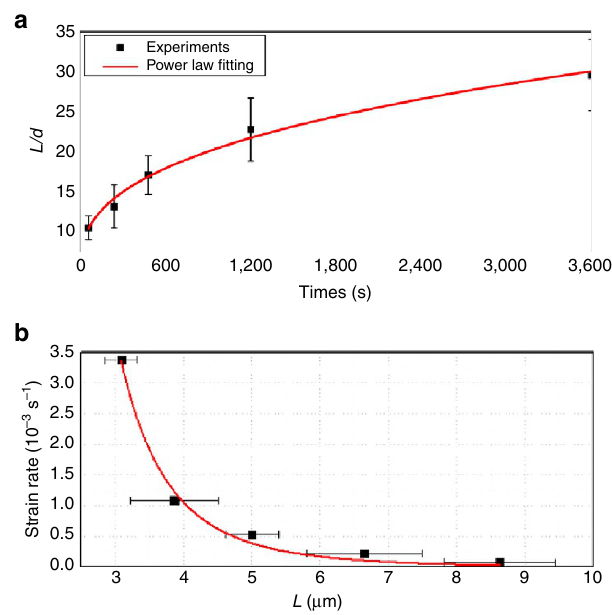
Figure 2 | Fabrication of Au nanowire arrays with controlled aspect ratios by SPNI. ( a ) The length of Au nanowires versus holding time, where five Au short rods with diameters of 2mm (61.8 ± 0.5mg) were superplastically formed into 200nm Al 2 O 3 templates at 500 (cid:2) C, under an applied force of 10kN and holding for 1, 4, 8, 20 and 60min (black dots), respectively. The best fitting result by using equation (3) gives L / d ¼ 4.65 þ 1.33 (cid:4) t 0.36 (red line). ( b ) The calculated apparent strain rate ( _ e app ¼ d ln L ð Þ = d t ) in the experiments is on the order of 10 (cid:2) 3 s (cid:2) 1 , and it is found scaling with L as _ e app / L (cid:2) 4 : 45 by fitting with a power law (red line). The error bars are defined as s.d. and obtained by measuring at least 10 nanowires for each sample.